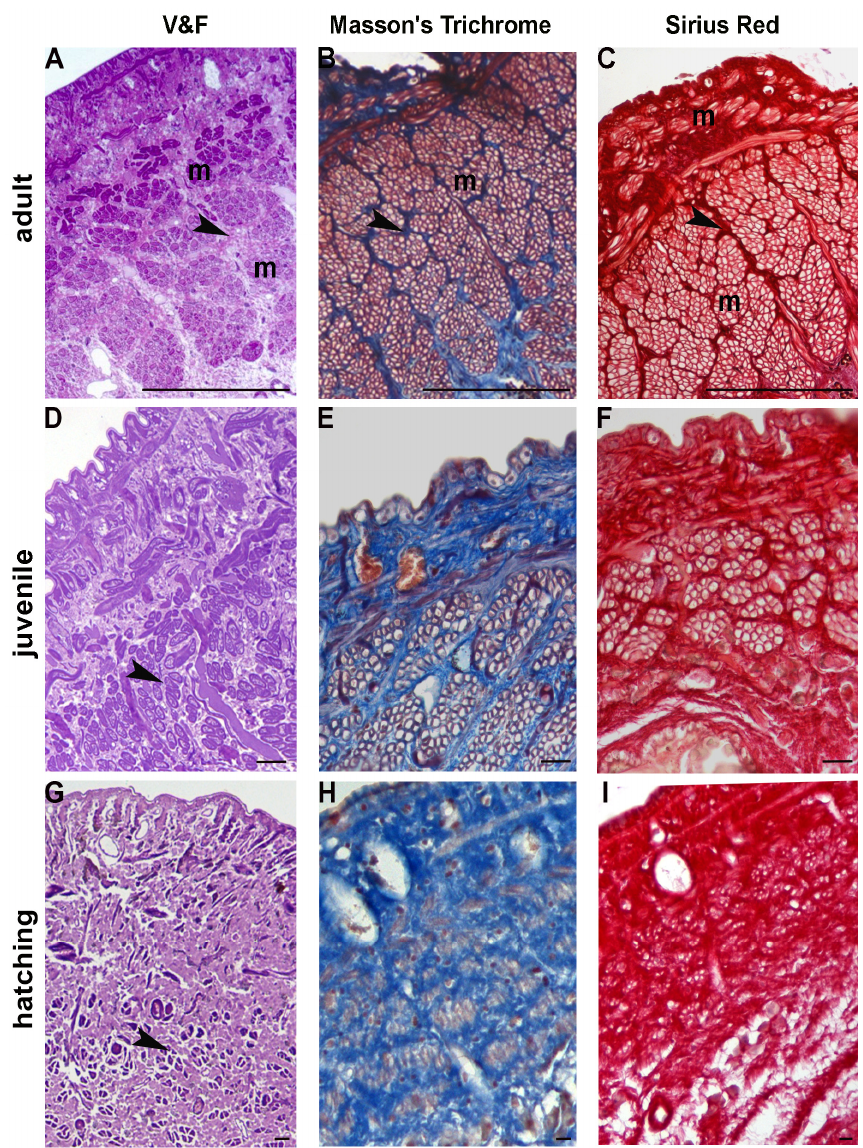
Figure 1. Adult, juvenile and recently hatched H. verbana in cross section. Optical